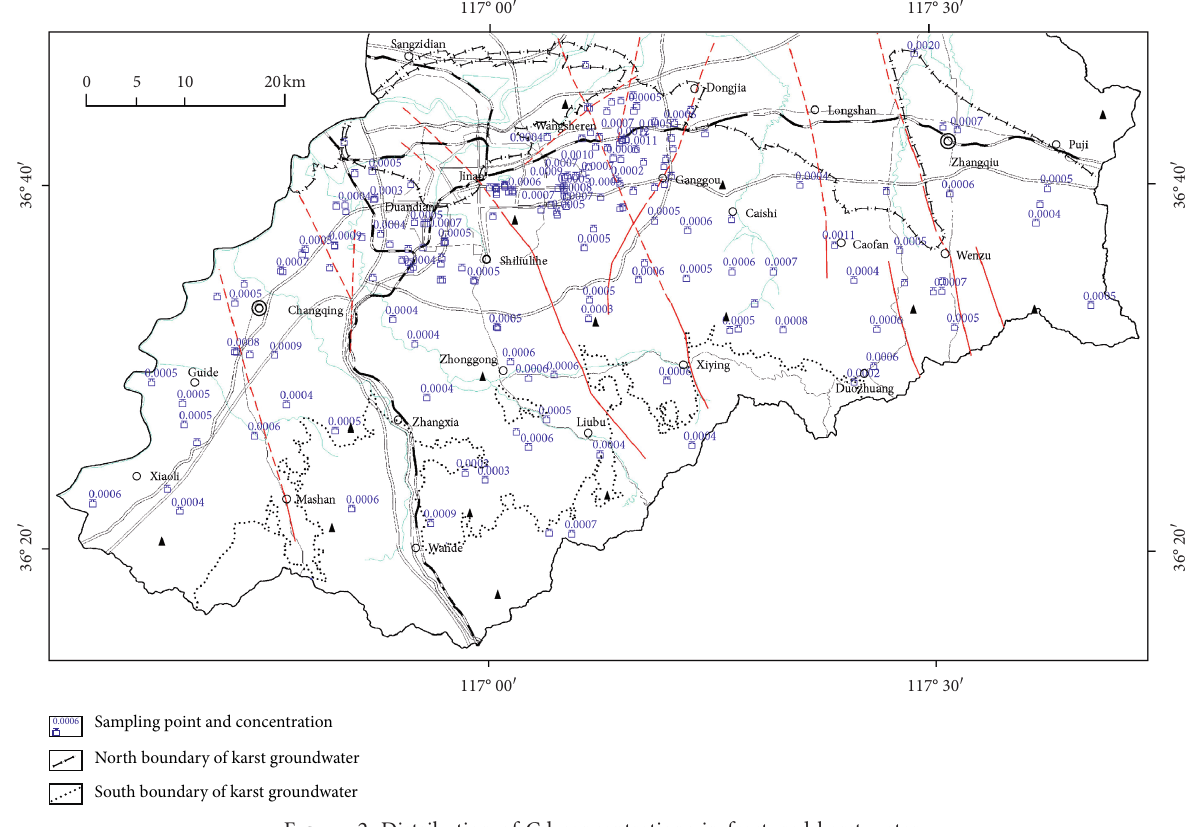
Figure 2: Distribution of Cd concentrations in fractured karst water.